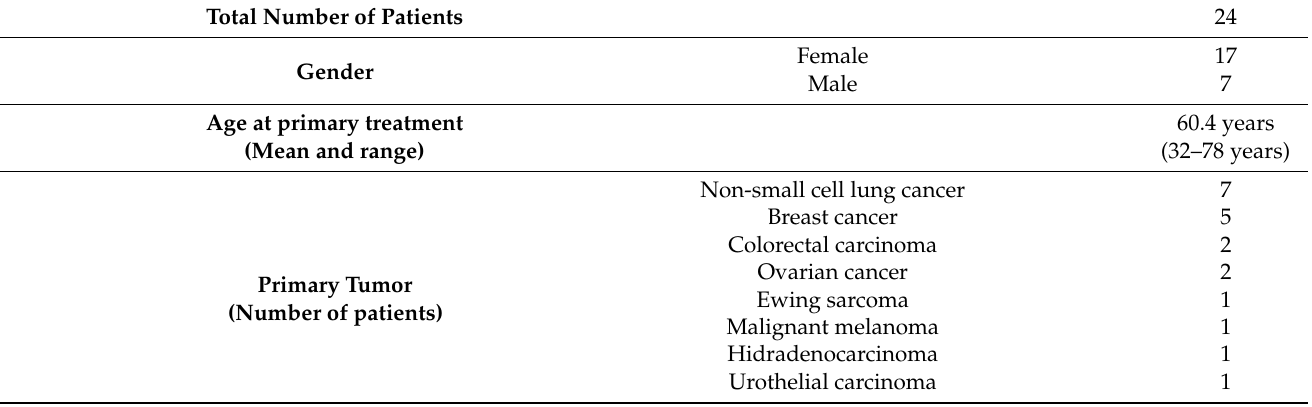
Table 1. Patient and tumor characteristics of 24 patients harboring metastases of different primary tumors close to motor-eloquent brain structures. All patients received preoperative navigated tran- scranial magnetic stimulation (nTMS)-based diffusion tensor imaging fiber tracking (DTI-FT mot.tms ) of the corticospinal tract (CST). After resection they were treated with radiotherapy in an adjuvant